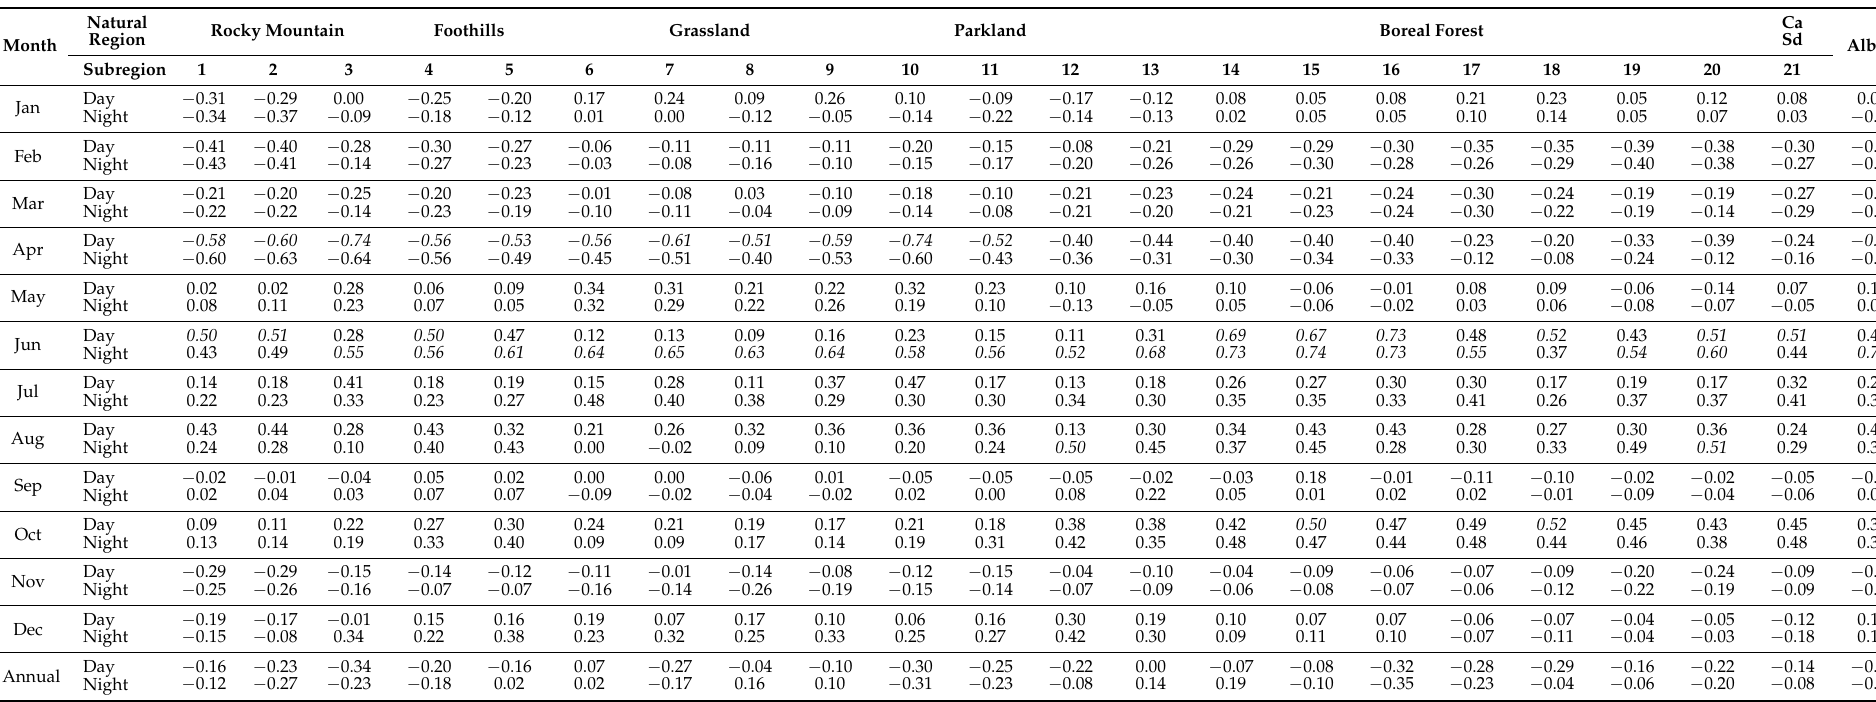
Table 6. Relations between day and nighttime LST and AO indices at both monthly and annual timescales, where acceptable correlations ( r ≥ 0.50) are highlighted italic. Natural Region Rocky Mountain Foothills Grassland Parkland Boreal Forest Month